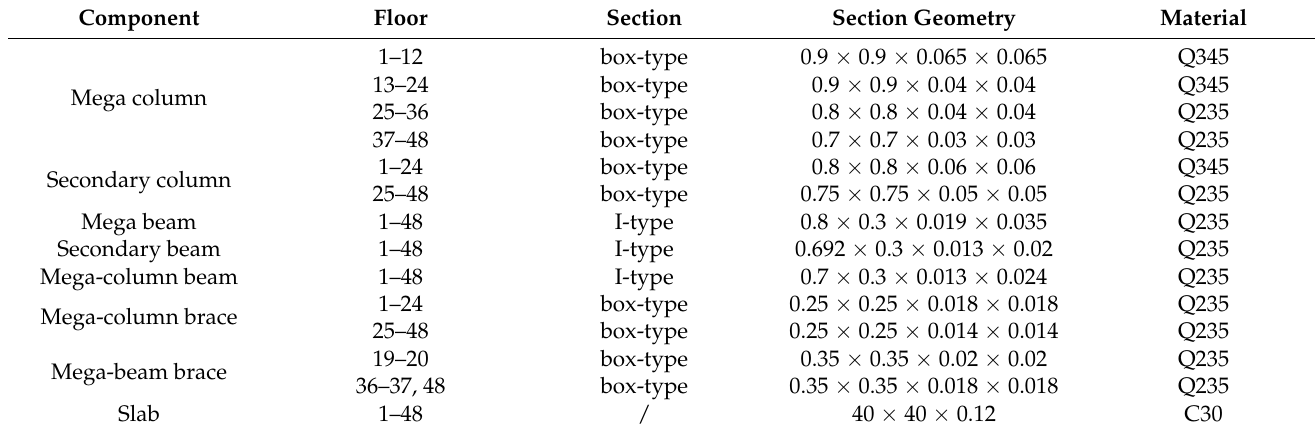
Table 1. Section geometries and materials of structural components (units: